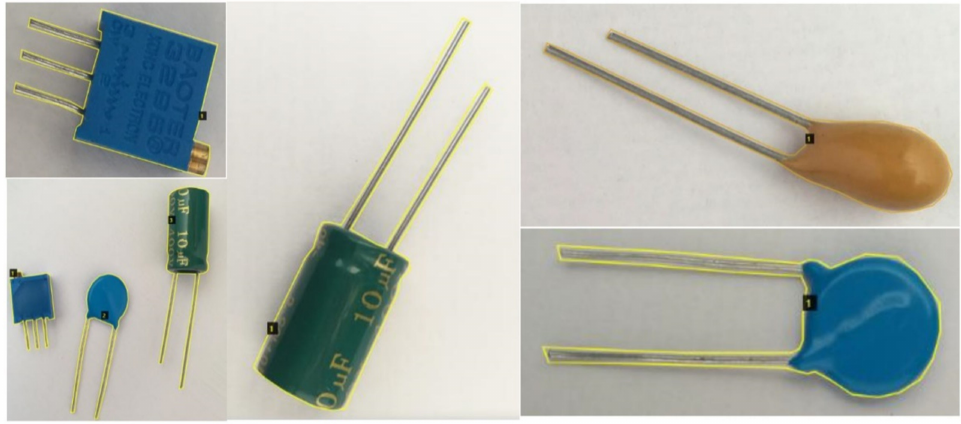
Figure 3. Examples of labelled images.